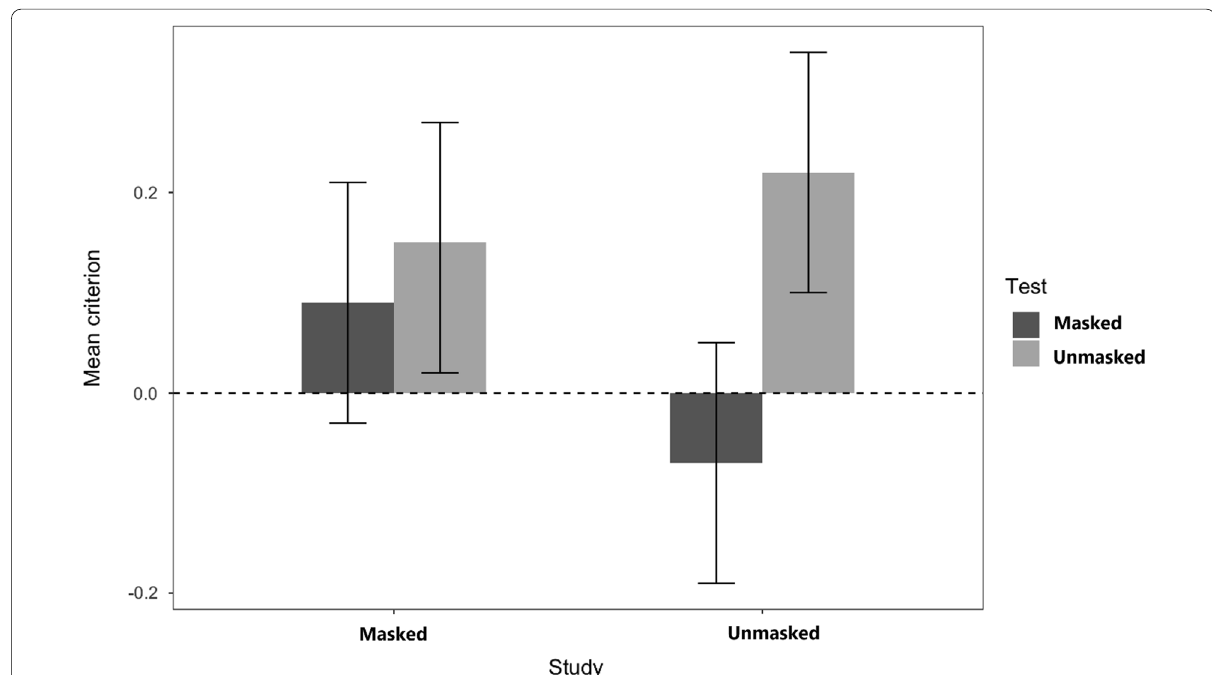
Fig. 3 Experiment 1: Criterion c. Note. Mean response criterion used for all participants regarding faces studied with and without a mask and subsequently tested either with or without a mask (Experiment